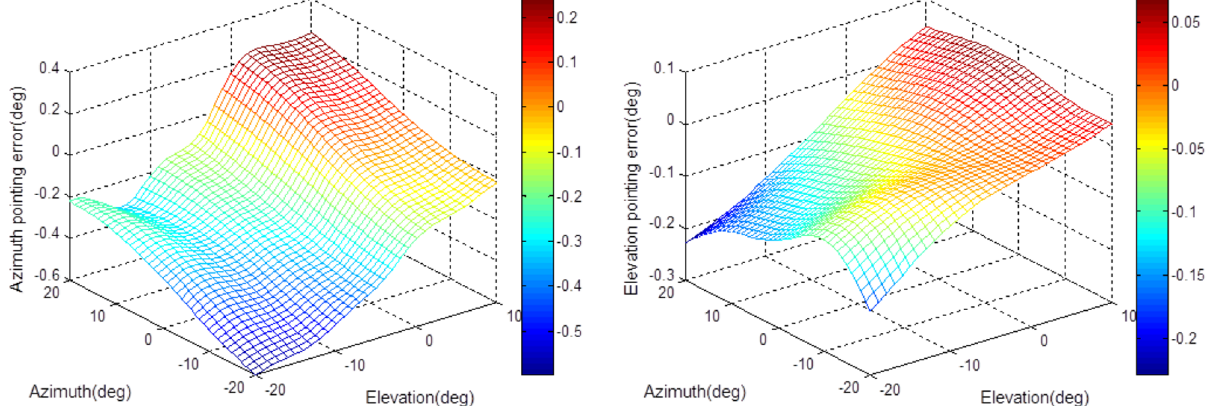
Fig. 2. Pointing error regression for azimuth and elevation.